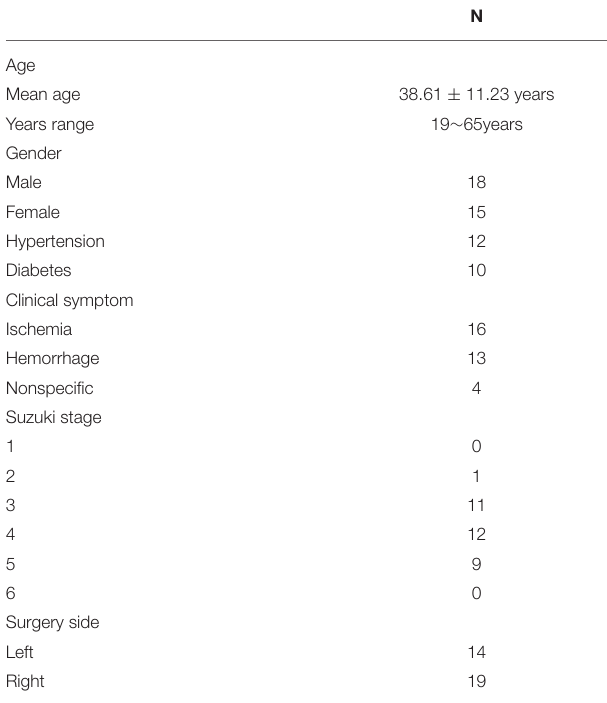
TABLE 1 | Clinical information of patients with moyamoya disease (MMD) (33